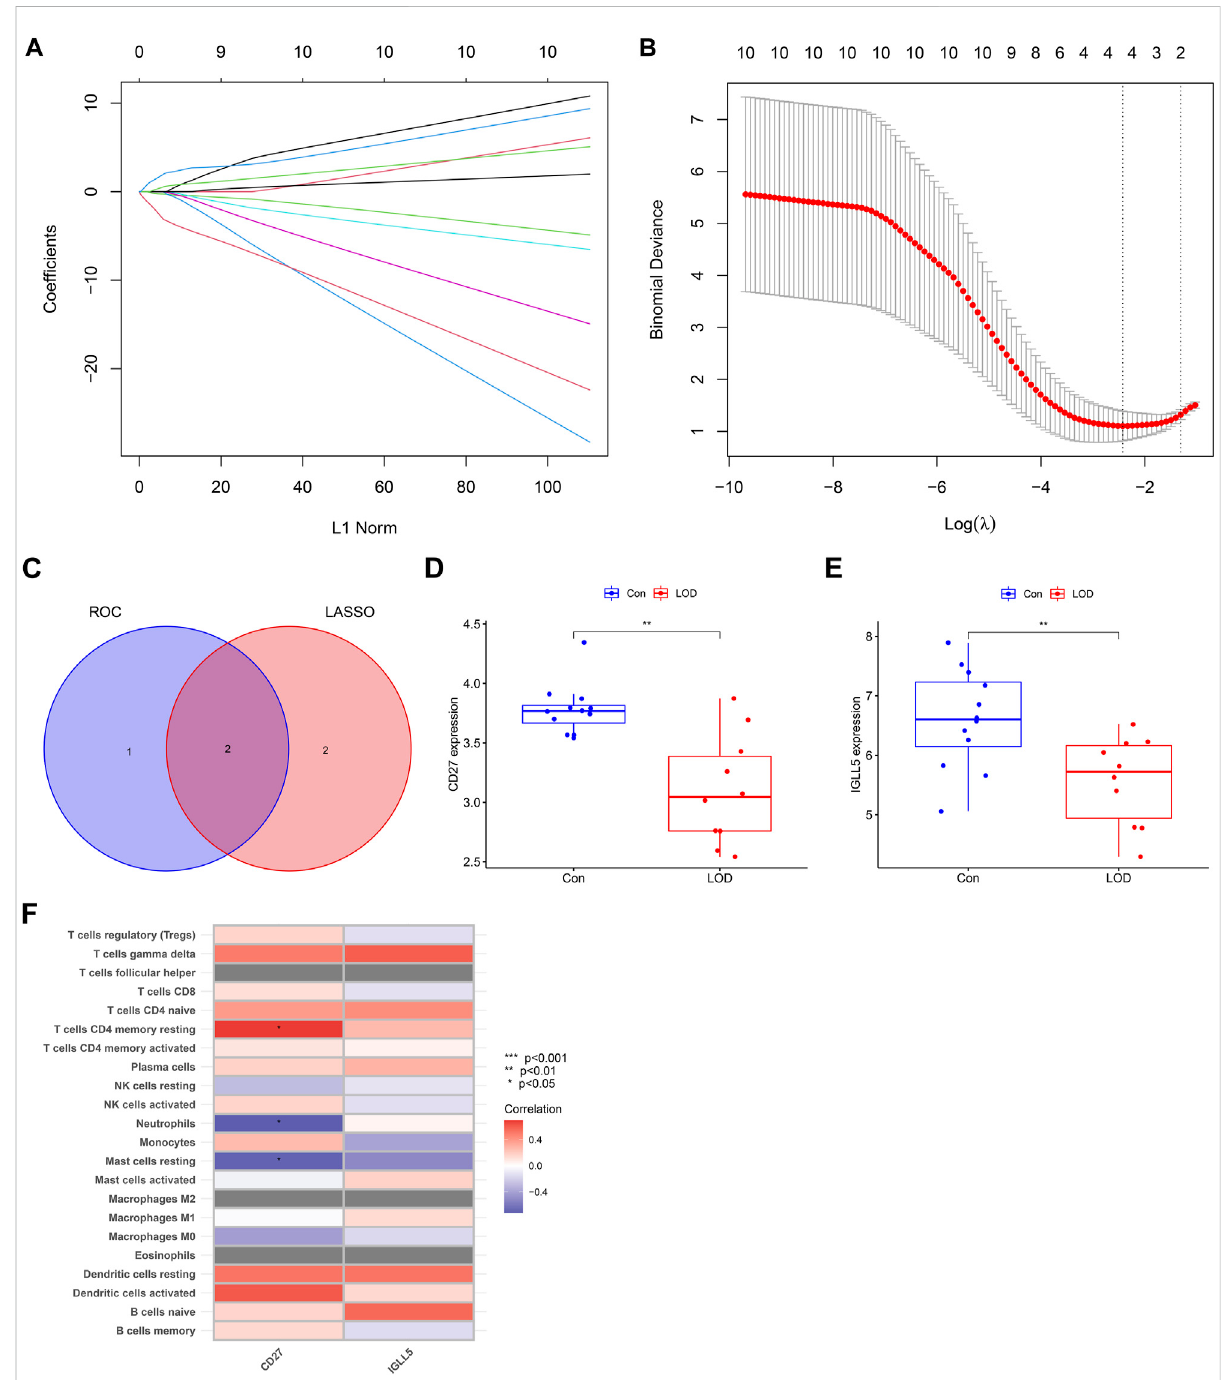
FIGURE 8 LASSO regression model and correlation between genes and immune cells. (A) Ten-fold cross-validation for tuning parameter selection in the LASSO model. (B) LASSO coef fi cient pro fi les for hub genes of LOD. (C) Venn diagram of the genes obtained from LASSO regression and the genes obtainedfromROC. (D,E) Boxplotsoftheexpressionsof CD27 and IGLL5 . (F) Heatmapofcorrelationsbetweengenes( CD27 and IGLL5 )andimmune